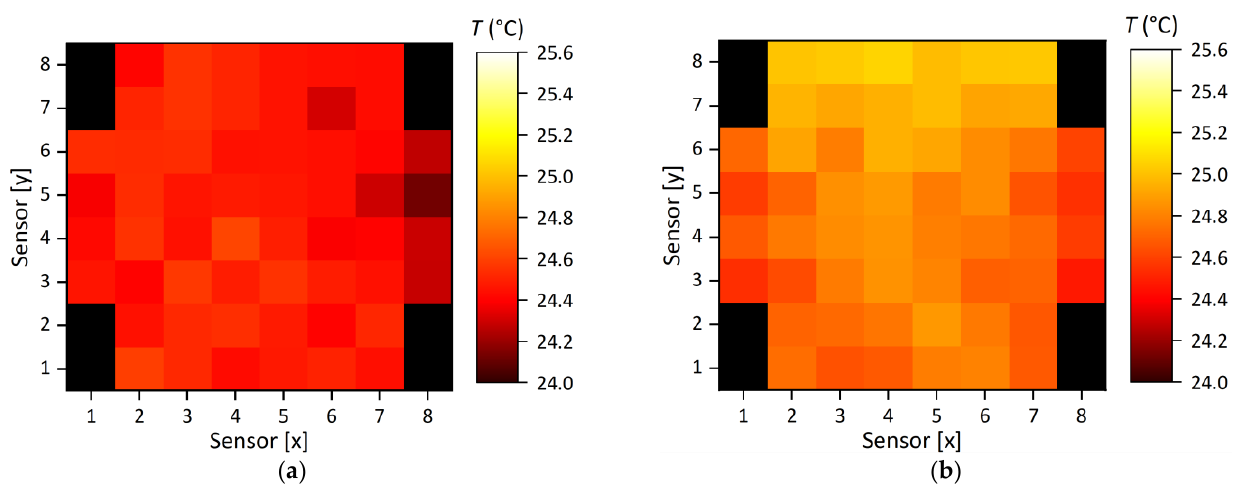
Figure 15. Temperature distribution after discharging with 1 C and activated cooling between ( a ) a pouch cell and cooling plate and ( b ) between two pouch cells. The water inlet is at the top left and the ambient temperature is 22 °C.